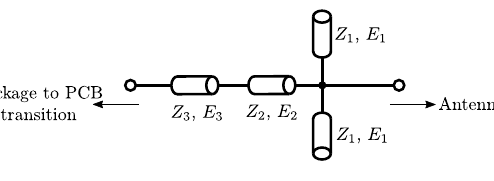
Figure 10. Matching network schematic. Table 1. Matching network transmission line electrical parameters at